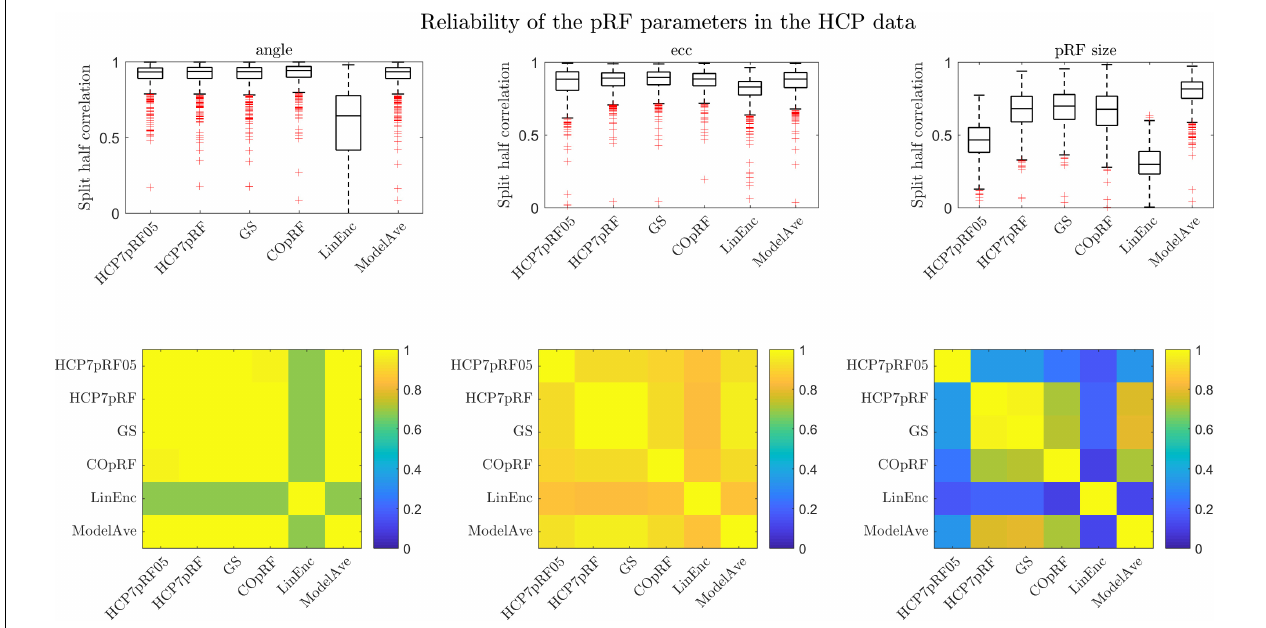
FIGURE 9 | The split-half reliability ([25, 50, 75] percentiles of the distribution across 181 subjects) for pRF parameters estimates for different methods. The correlation between the parameters estimated by the different methods (across all ROIs) is presented in the bottom row.